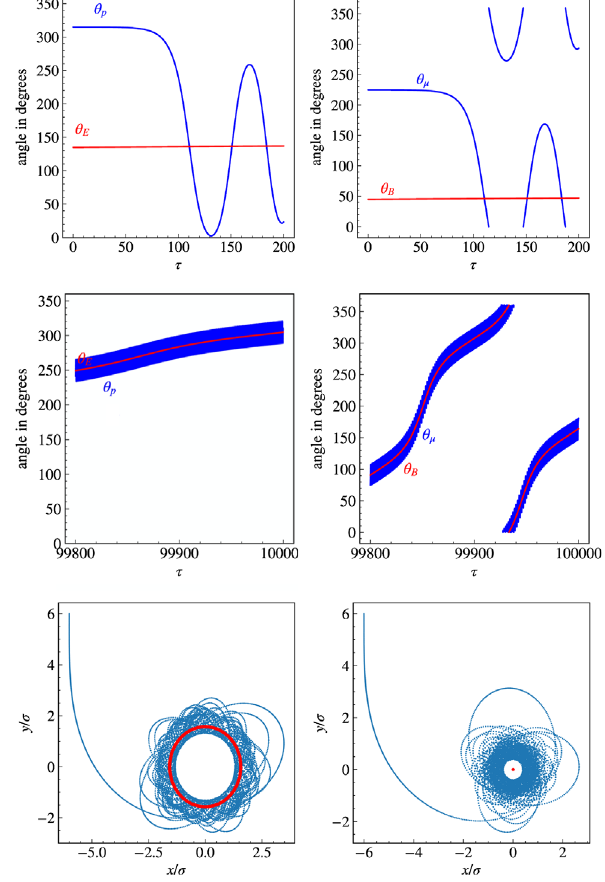
FIG. 24. Simulated angles of a molecule ’ s ⃗ p (blue) and local ⃗ E electric field (red), with respect to the horizontal direction, at the start (top left) and end (center left) of an adiabatic increase of the electric field of the beam, over a total time T that would correspond to τ ¼ 10 5 periods of phase advance ω E T . The panels on the right present the simulated angular direction of a molecule ’ s magnetic dipole moment ⃗ μ (blue) and of the local ⃗ B magnetic field (red) during an analogous ramp-up of the beam ’ s magnetic field, over the same number of periods of phase advance ω T . The top and center panels each present the behavior over a B time interval Δ τ ¼ 200 . The bottom panels show the molecules ’ trajectories over the full simulation. The red circle in the bottom left panel indicates the equilibrium position r e — compare Fig. 13 and Eq.